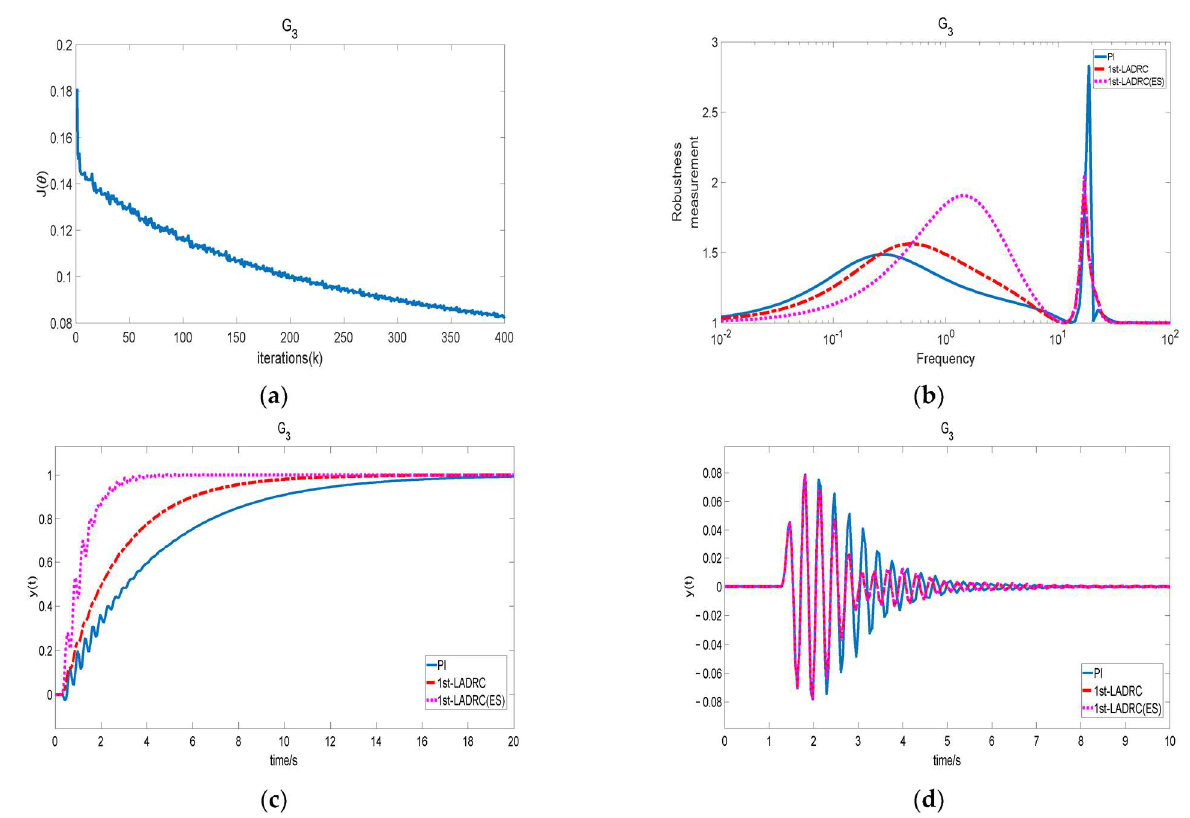
Figure 9. ( a ) Evolution of the cost function; ( b ) robustness of controllers; ( c ) output signal; ( d ) disturbance responses during experiments of a closed-loop system with G 3